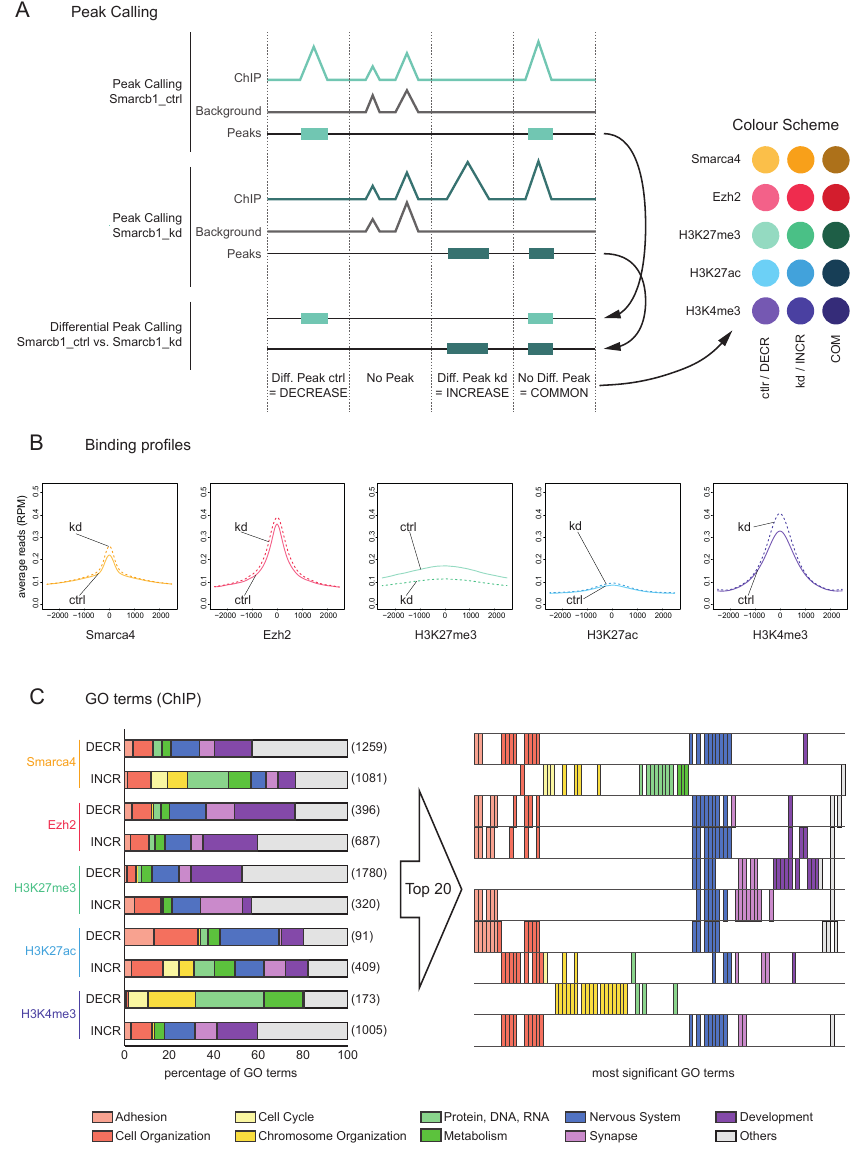
Figure 3. Smarcb1 loss causes binding changes in regions related to Adhesion , Cell Organisation , Nervous System and Development ( A ) Schematic overview of ChIP-seq peak calling. First, peaks have been called by comparing the antibody sample (“ChIP”) to their corresponding IgG control (“Background”). For evaluation of changes in binding, differential peak calling was performed. ChIP-seq results of control and Smarcb1 -kd cells (after 72 h) were compared, resulting in the definition of three groups: DECREASE (more binding in the control sample), INCREASE (more binding in the Smarcb1 -kd sample) and COMMON (no significant difference in binding). ( B ) LOESS-smoothed average binding profiles for all antibodies of this study. Control samples are depicted in a lighter colour scheme and Smarcb1 -kd samples in darker colours. ( C ) GO terms assigned to genes with either a DECREASE or an INCREASE in the respective antibody further classified into categories. On the left-hand side, a summary of these categories is given; on the right-hand site, only GO terms within the top 20 (ranked by p value) in at least one antibody are included. In parenthesis, the total number of GO terms are